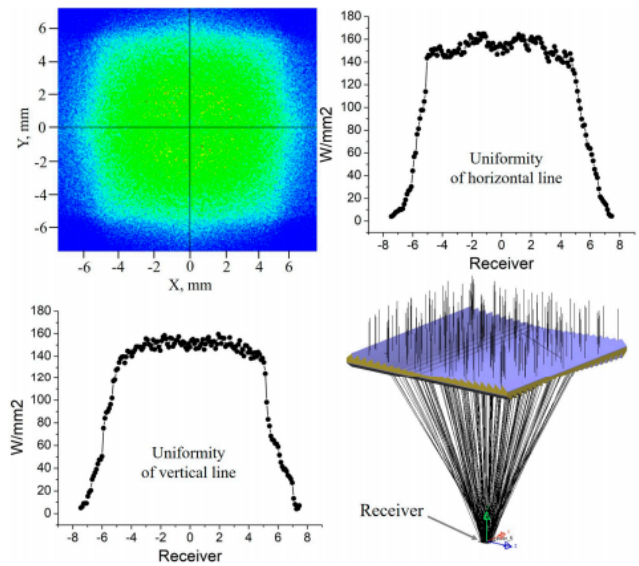
Figure 13. Flux distribution on the receiver in the horizontal and vertical directions [20]. Reprinted from T. Pham et al., Novel Design of Primary Optical Elements Based on a Linear Fresnel Lens for Concentrator Photovoltaic Technology, Energies 2019, 12, 1209, with permission from Elsevier.